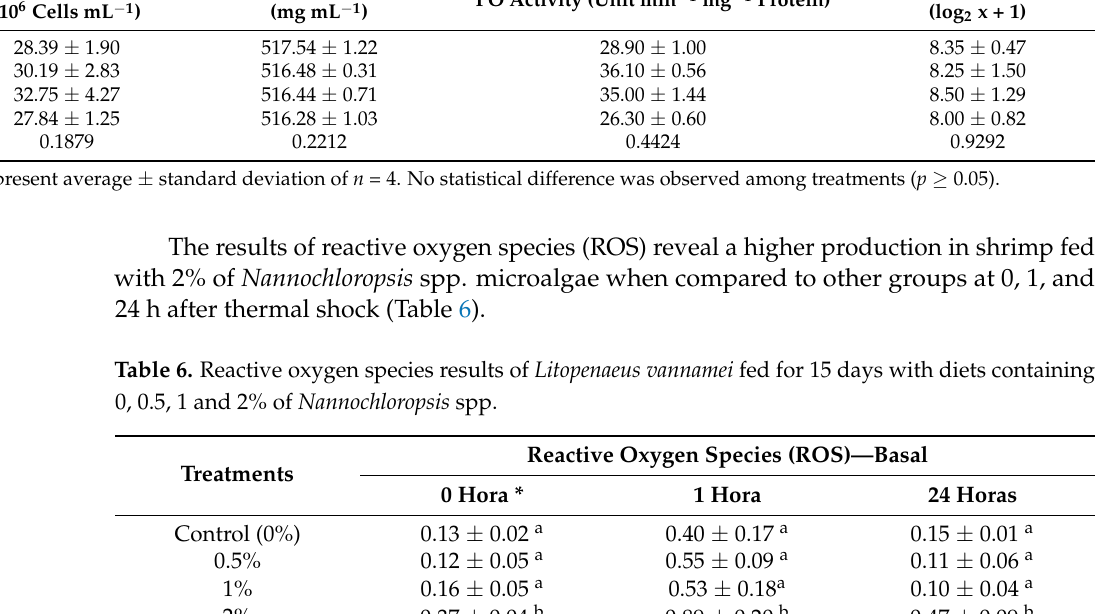
Table 5. Immunological parameters (hemocyte counts, protein concentration, phenol-oxidase activity and agglutination titer) of Litopenaeus vannamei fed for 15 days with diets containing 0, 0.5, 1 and 2% of Nannochloropsis spp. Treatments